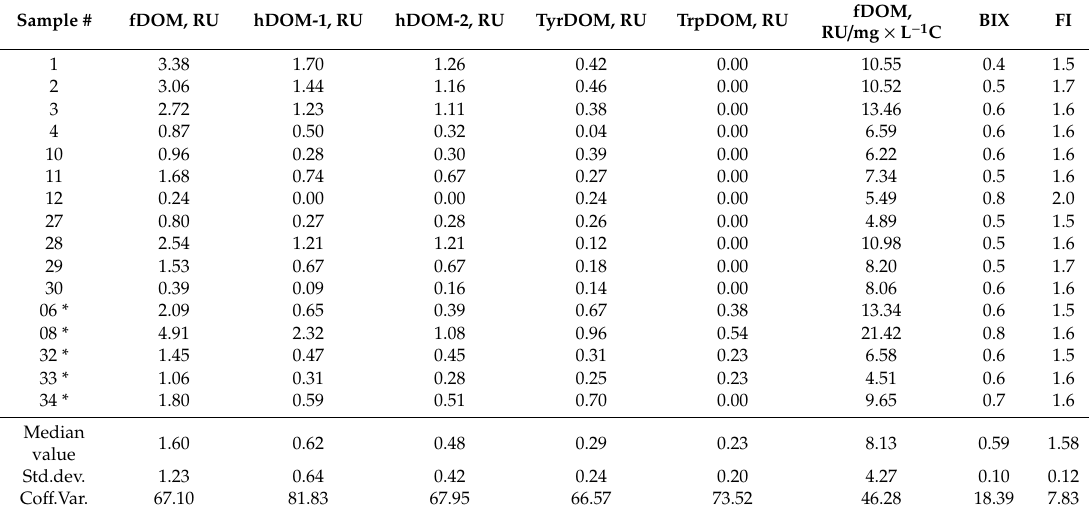
Figure 4. The representative excitation-emission (EEM) spectra of DOM, sample numbers are * tabular ground ice samples are marked with an asterisk. indicated in the left upper part of each spectrum. The peak marks are 1—hDOM-1; 2—hDOM-2; 3— tyrDOM; 4—trpDOM. * tabular ground ice samples are marked with an asterisk.